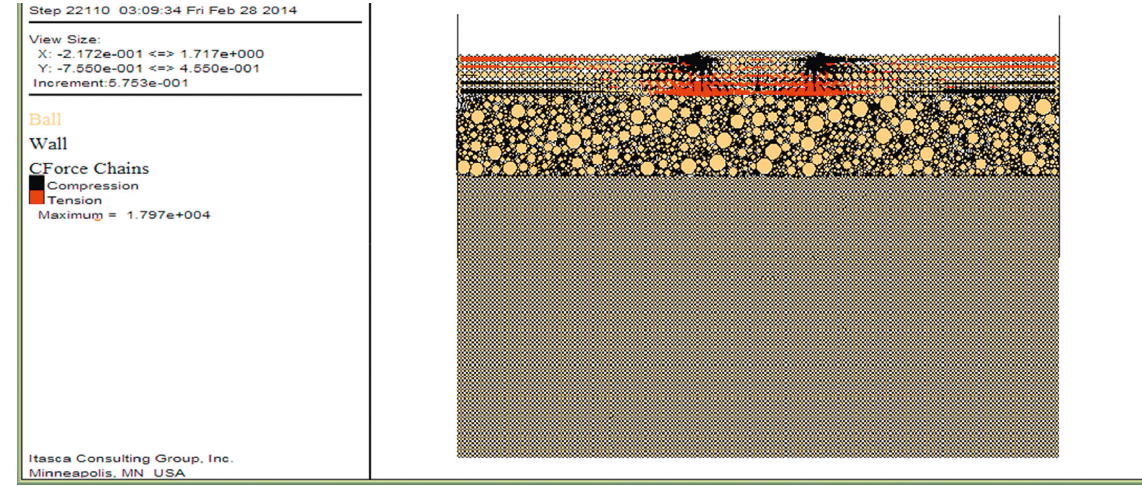
Figure 4: Stress distribution of the asphalt layer (black and red denote pressure and tension, resp.).